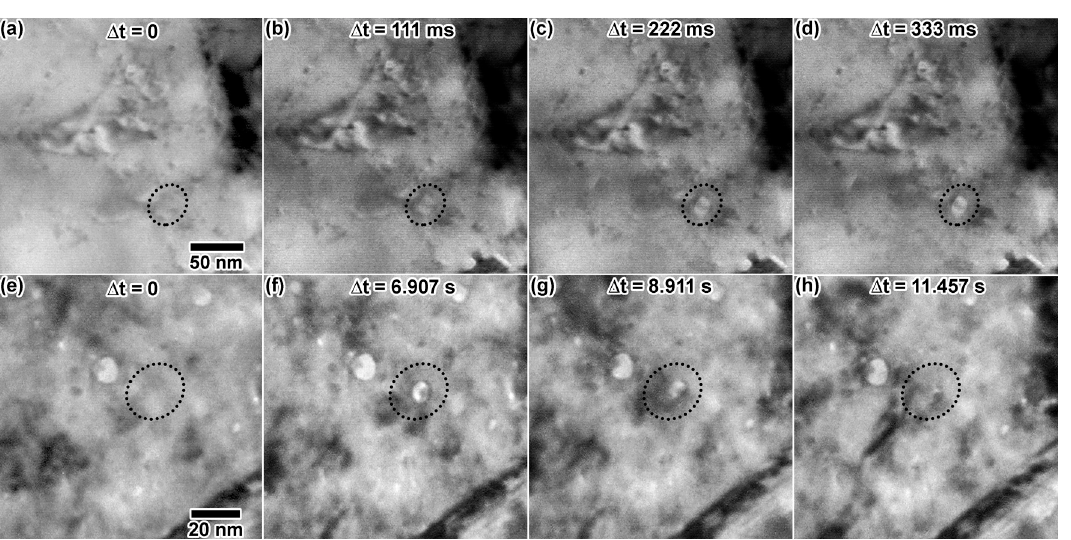
Figure 9. In situ TEM images showing cavity growth as a function of time due to ( a – d ) double ion irradiation with 5 keV D + 1.7 MeV Au and cavity formation and collapse as a function of time due to ( e – h ) triple ion irradiation with 10 keV He, 5 keV D and 2.8 MeV Au. Dashed circles highlight the cavity of interest in each image. Approximate fluences in (e–h) were Au: 1.2 × 10 13 , He: 1.3 × 10 15 and